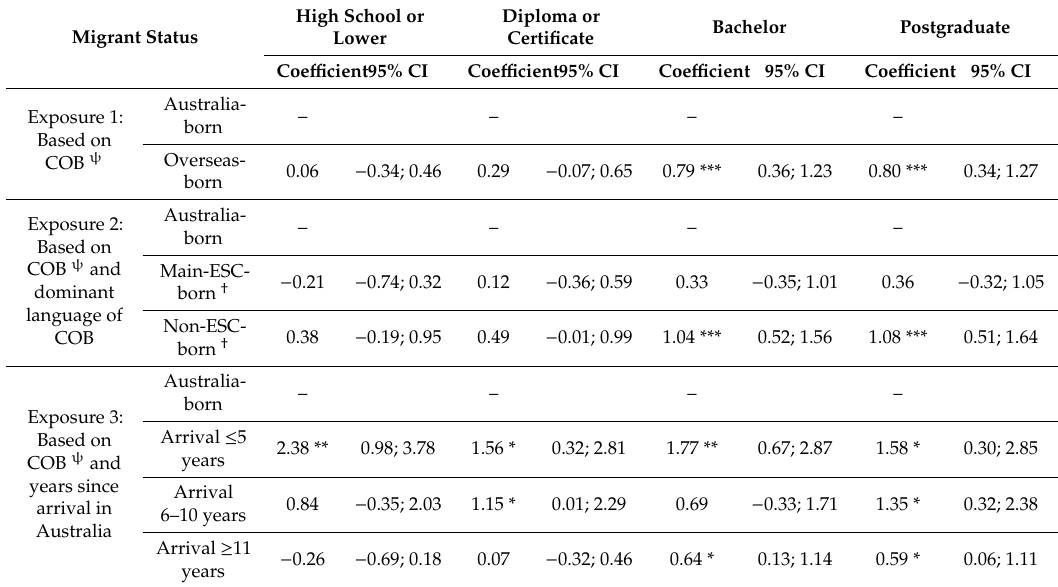
Table 3. Mean di ff erences in job insecurity between Australia-born workers and migrant workers by educational attainment, adjusted for gender and age ( n =